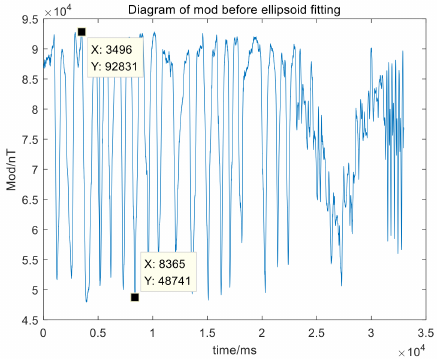
Figure 9. Diagram of modules before